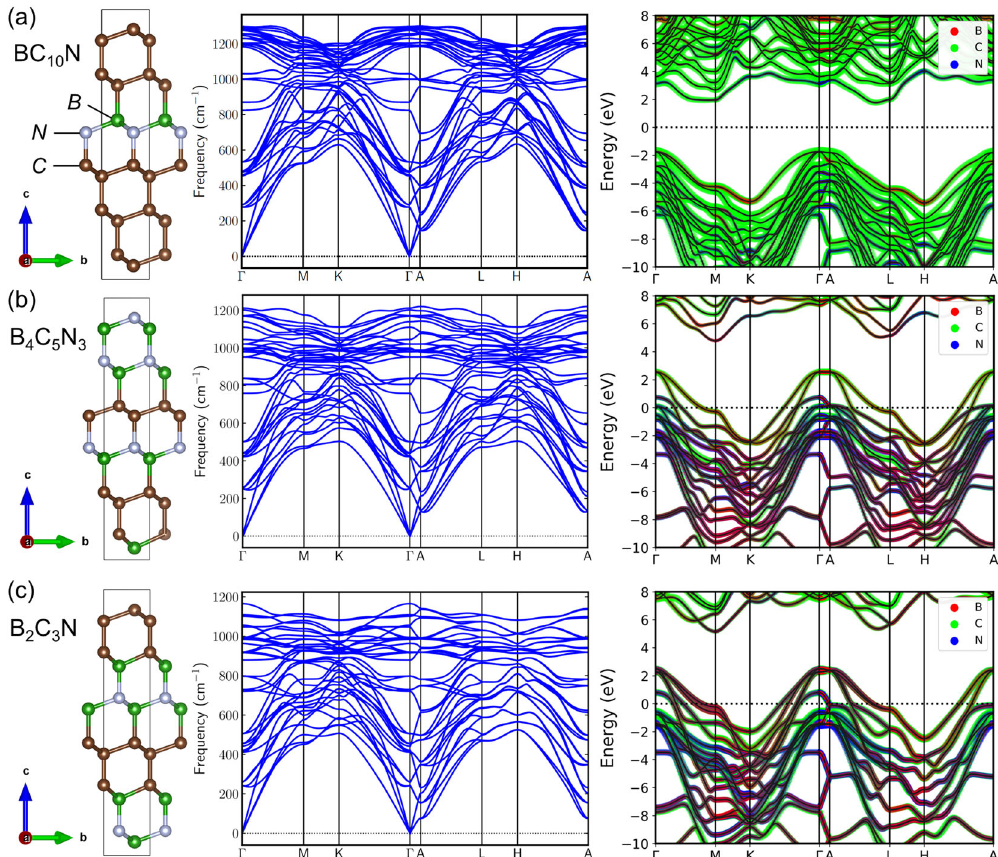
Fig. 5 Evolutionary algorithm and density functional theory calculations. Theoretical crystal structures (left panels), phonon dispersion spectra (middle panels), and electronic band structures (right panels) for a BC 10 N, b B 4 C 5 N 3 , and c B 2 C 3 N. BC 10 N is a wide band gap insulator, while B 4 C 5 N 3 and B 2 C 3 N are both metals. All three compounds are dynamically stable (i.e., without negative phonon modes). The crystal structures are visualized by the VESTA software 88